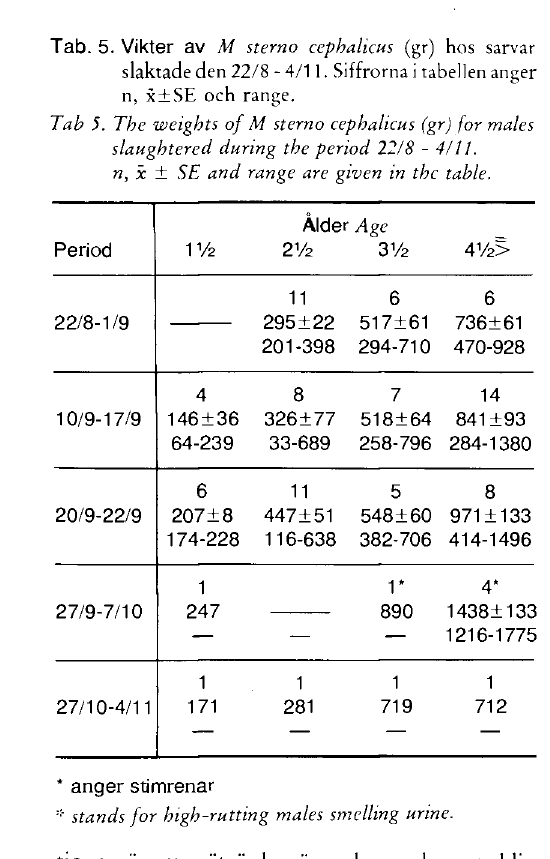
Tab. 6. Linjar regression mellan M stemo cephalieus (%o av totala slaktvikten) och plasmatestosteron- koncentrationen (ng/ml) i olika åldersklasser. Tab 6. Linear regression of M sterno cephalicus (%i> of the total carcass weight) and the plasmatestosteron concentration (ng/ml) of different age